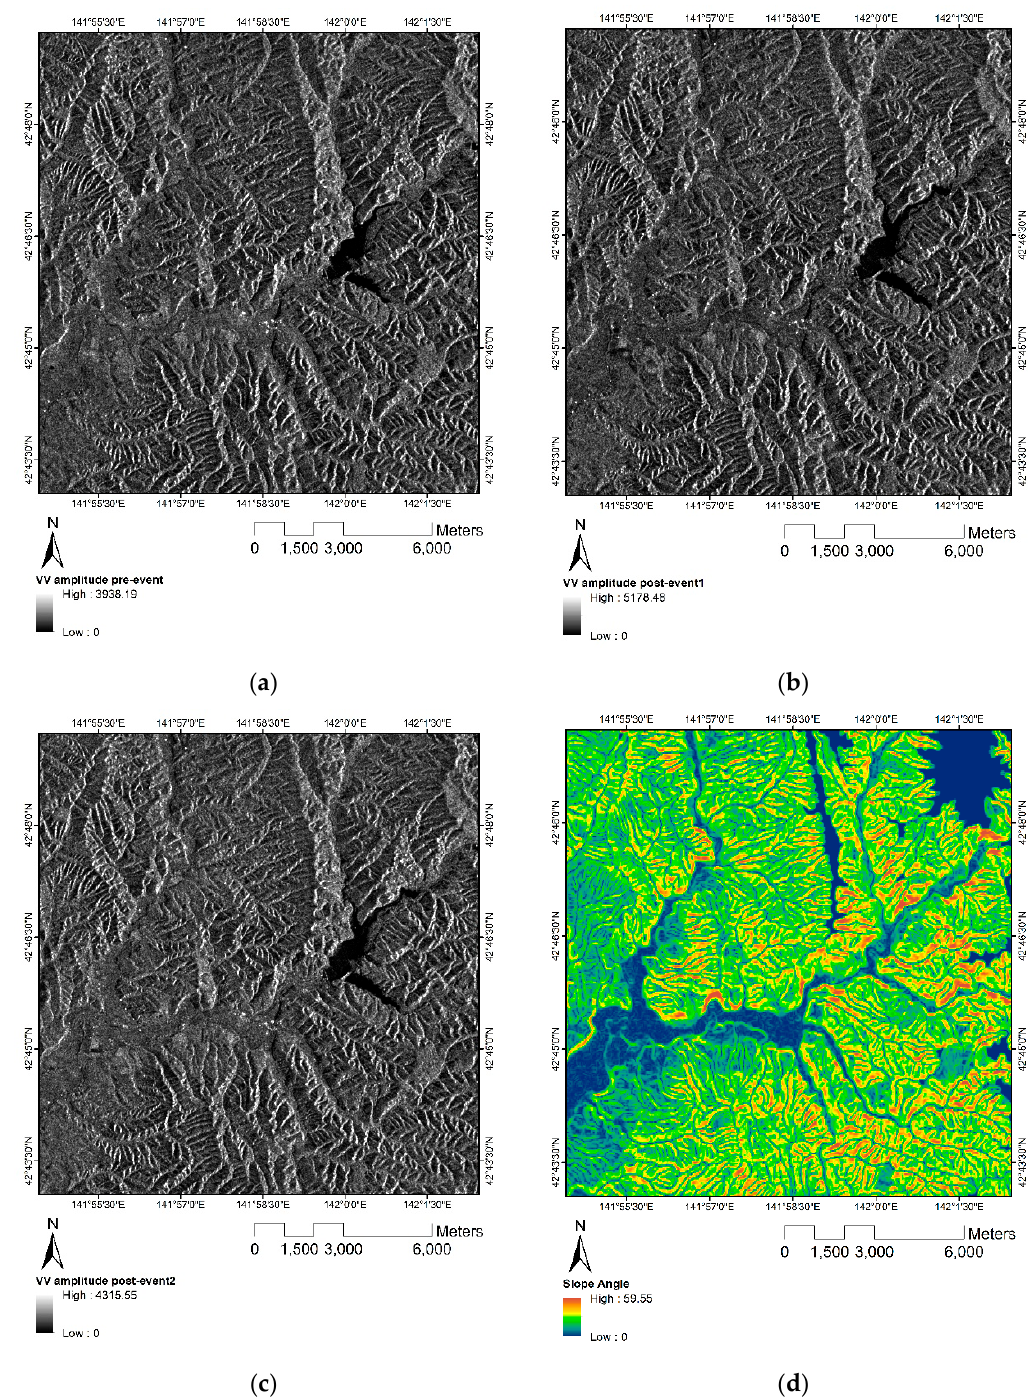
Figure 2. Data employed to create the composite images BAA_S and BA_S. ( a ) VV amplitude pre-event, ( b ) first VV amplitude post-event, ( c ) second VV amplitude post-event, and ( d ) slope